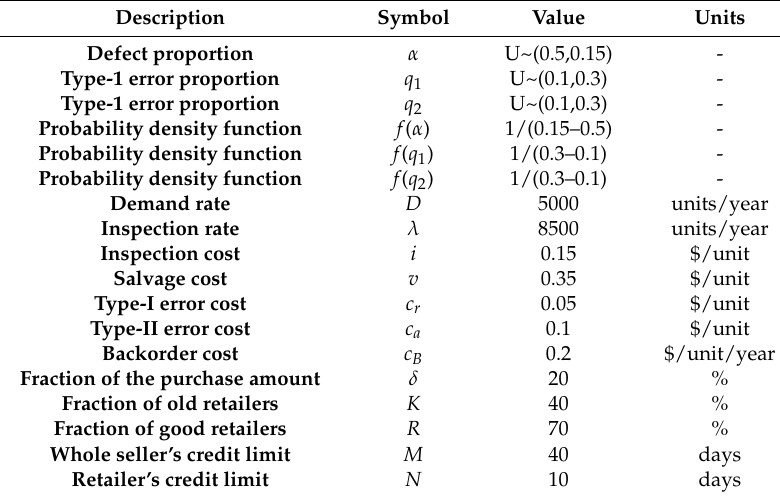
Table 4. Other parameters for the numerical